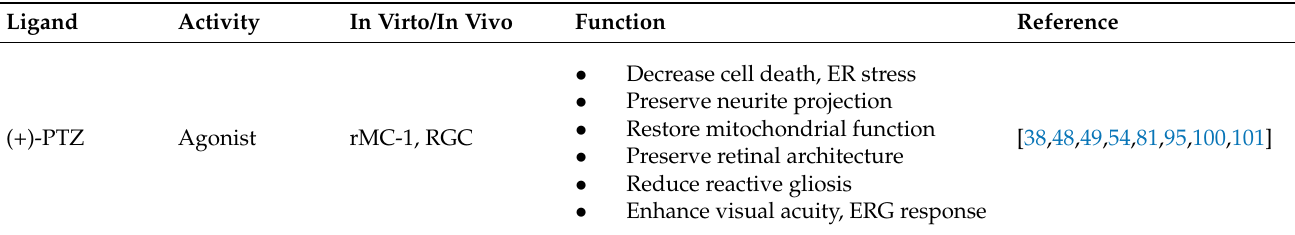
Table 1. Ligands of sigma-1 receptor in retinal pharmacological